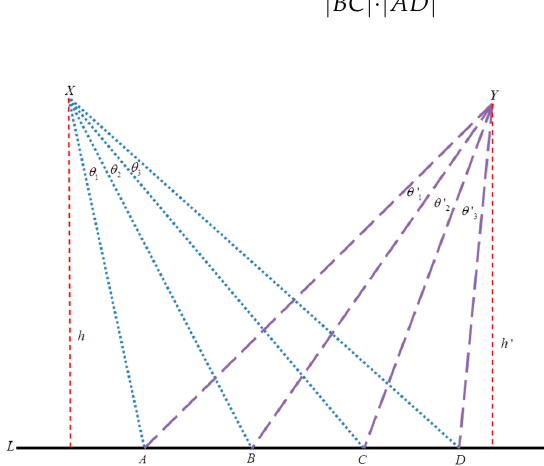
Figure 3. The cross ratio relationship of two viewpoints.